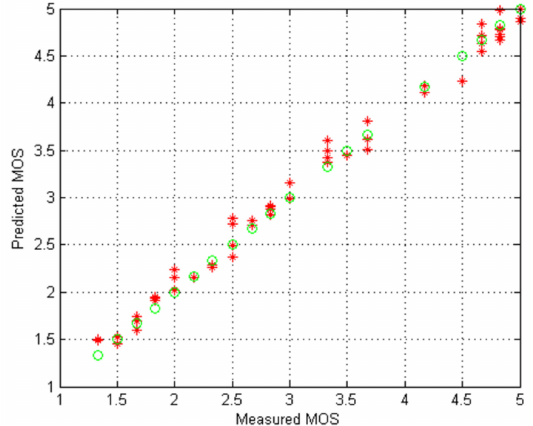
Figure 17. Subjective MOS vs. predicted MOS for tablet.